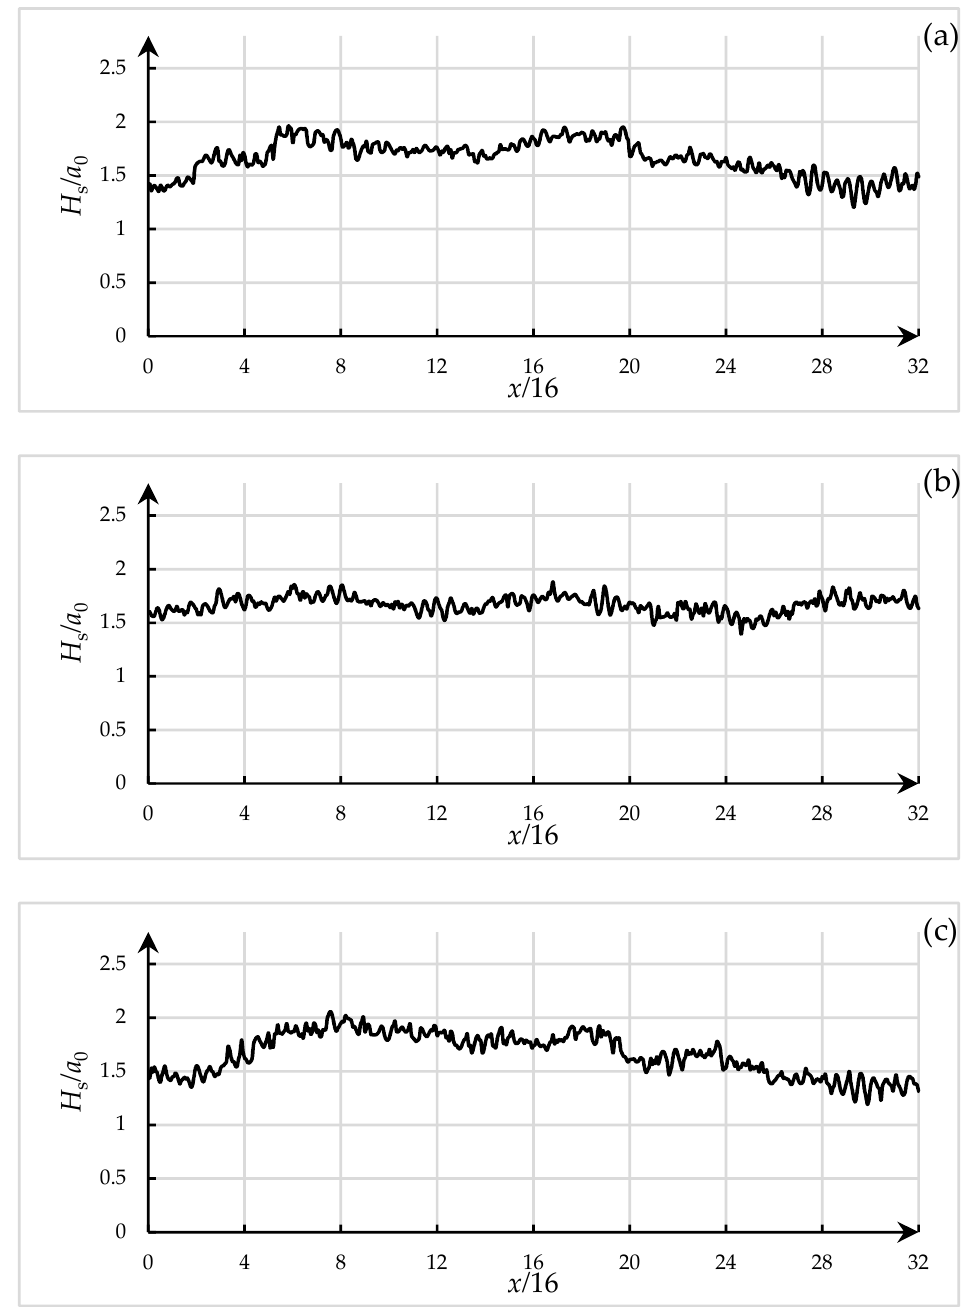
Figure 6. Distributions of significant wave heights H s along the x -axis under three random initial phases for M = 3: ( a ) Initial phase one; ( b ) Initial phase two; ( c ) Initial phase three.